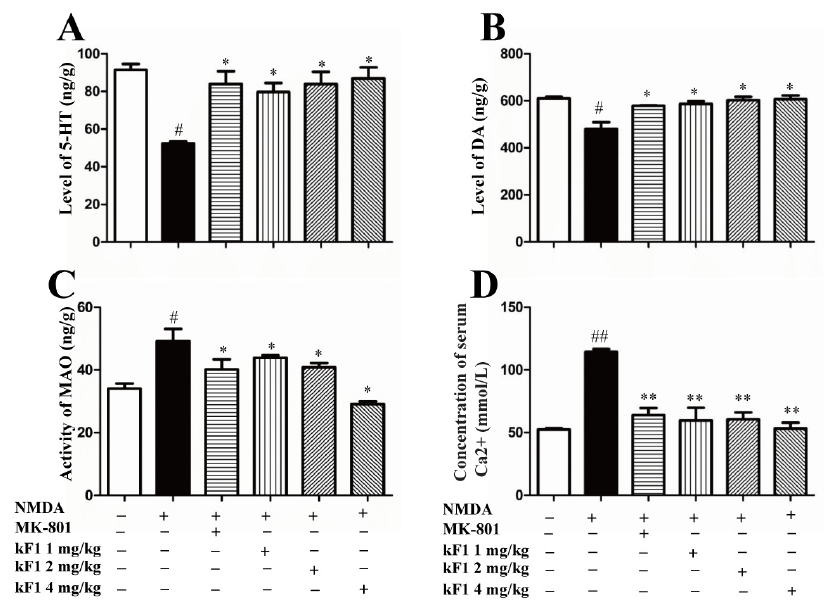
Figure 6. Effects of KF1 on neurotransmitters, MAO levels, and Ca 2+ concentration in the hippocampus. The levels of 5-HT ( A ) and DA ( B ); the activities of MAO ( C ) and Ca 2+ ( D ) concentration in the hippocampus of NMDA-induced mice. The data are expressed as means ± SEM ( n = 8); # p < 0.05, ## p < 0.01 versus vehicle group; * p < 0.05, ** p < 0.01 versus NMDA group.